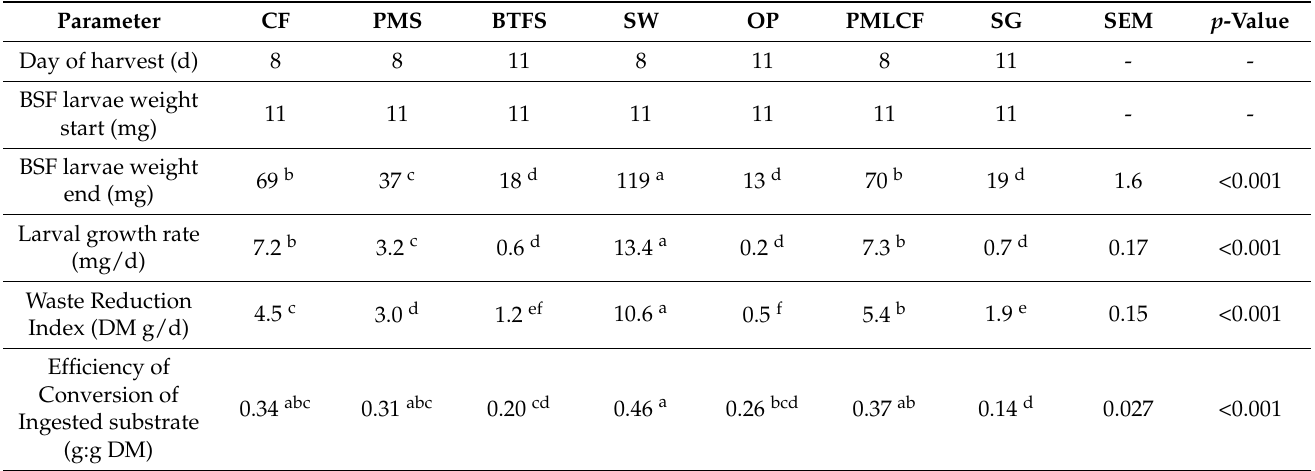
Table 3. Growth performance (fresh live weight), Waste Reduction Index (dry matter) and Efficiency of Conversion of Ingested substrate (dry matter) of BSF larvae grown on seven different substrates 1